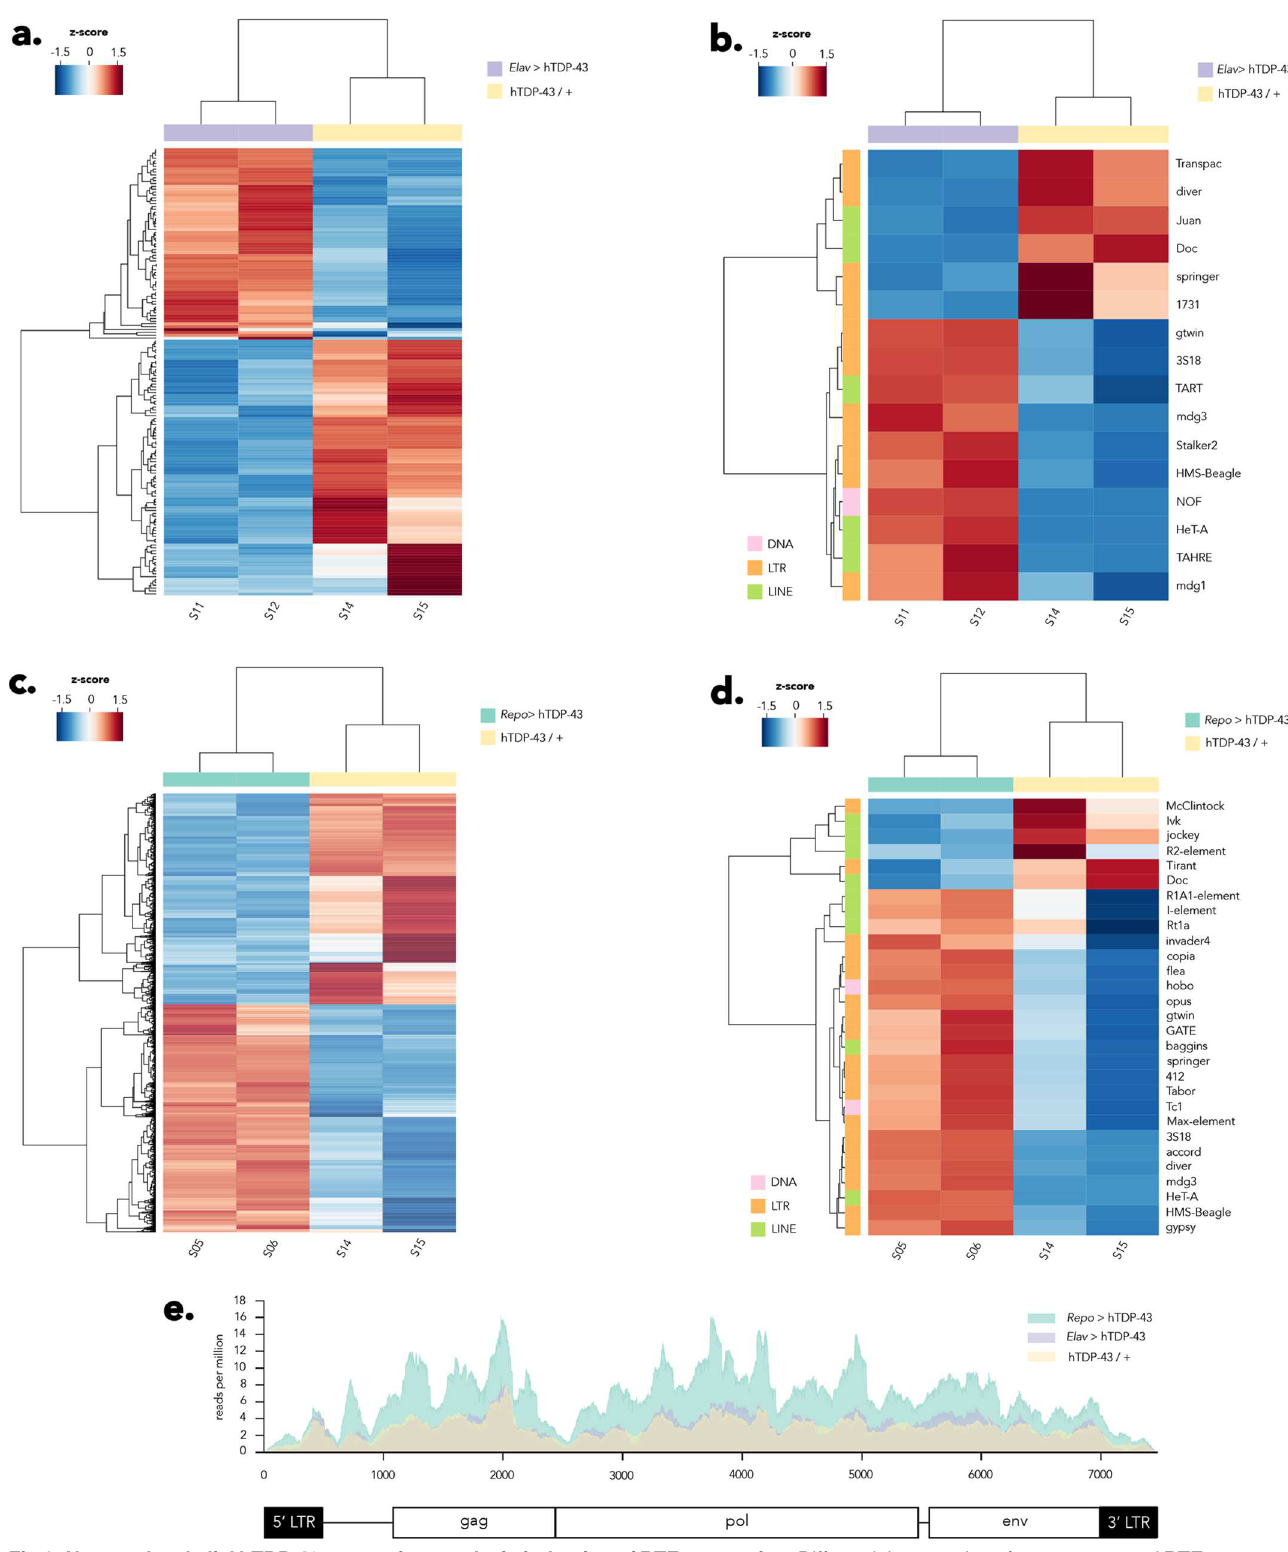
Fig 1. Neuronal and glial hTDP-43 expression results in induction of RTE expression. Differential expressionof many genesand RTEs are detected in responseto either neuronalor glial expressionof hTDP-43 in head tissue of 8–10 day old flies ( N = 2 biologicalreplicatesper